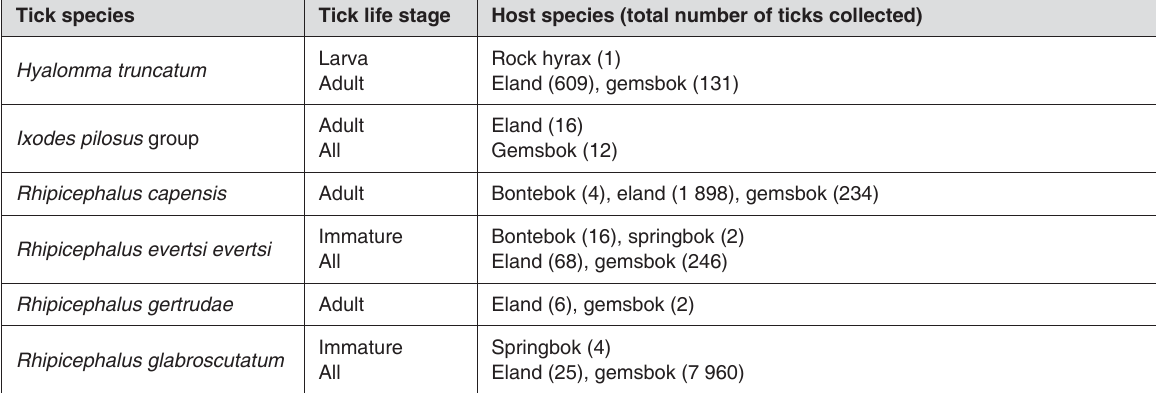
TABLE 3 Ixodid ticks collected from mammals in the West Coast National Park, South Africa Tick species